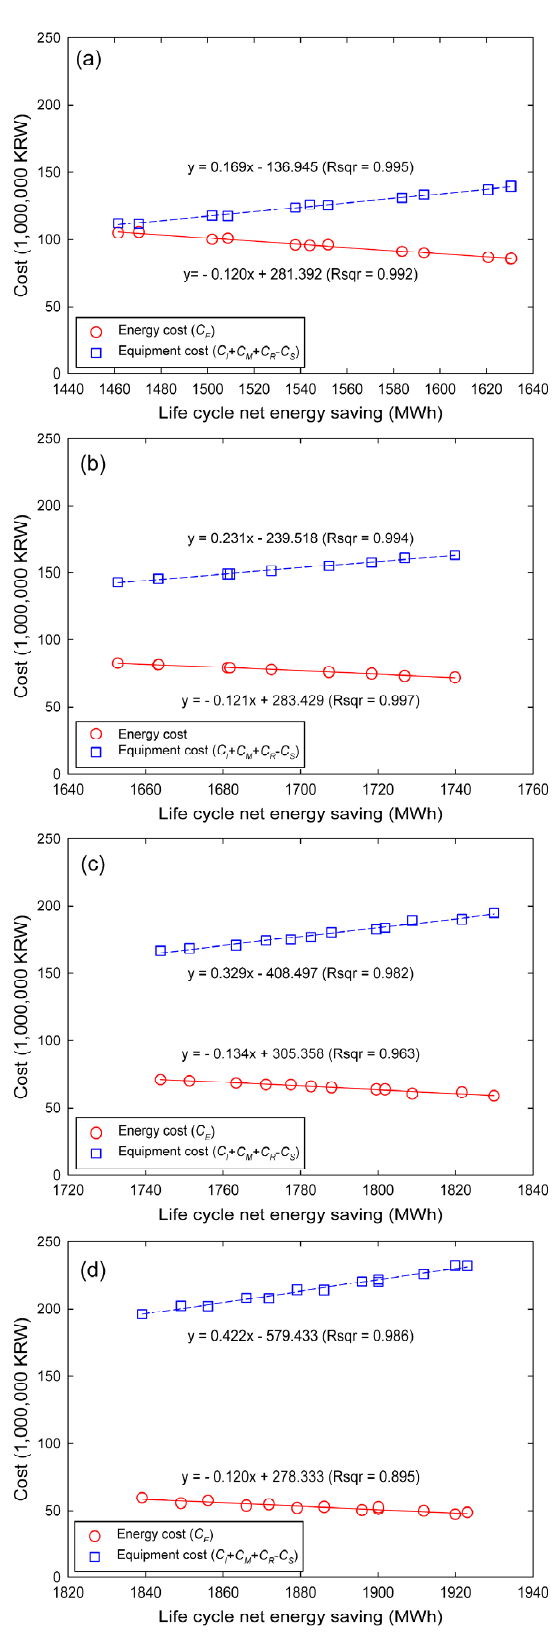
Figure 7. Correlation between cost and energy saving of Pareto frontier for last generation: ( a ) Cluster 1; ( b ) Cluster 2; ( c ) Cluster 3; and ( d ) Cluster 4.